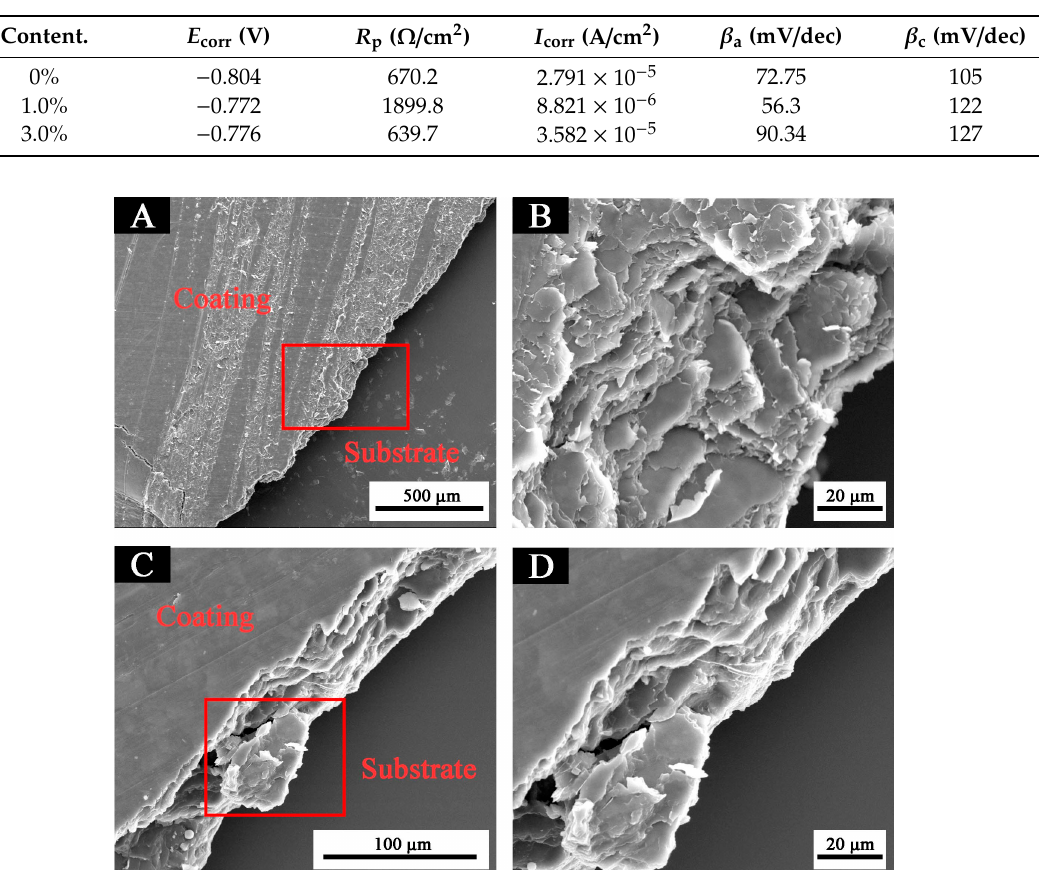
Figure 11. Cross-section scanning electron microscopy of coatings with different black paste contents coating: ( A ) 1.0% and ( C ) 3.0%. ( B ) and ( D ) are the zoomed views of the red boxes in ( A ) and ( C ), respectively.